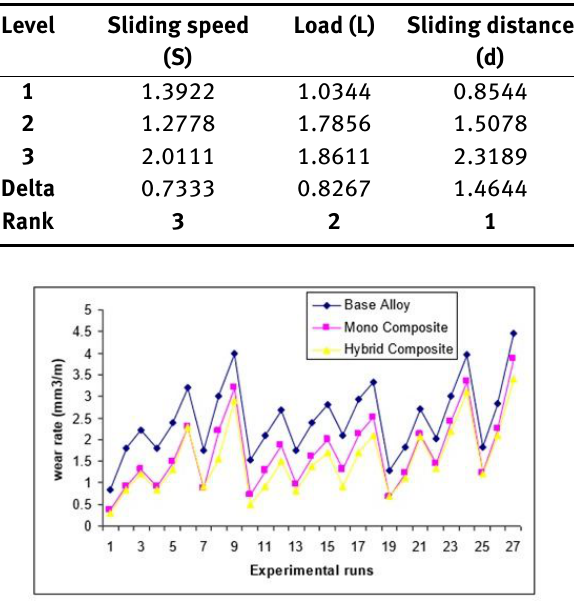
Figure 5: Comparison of experimental results for base